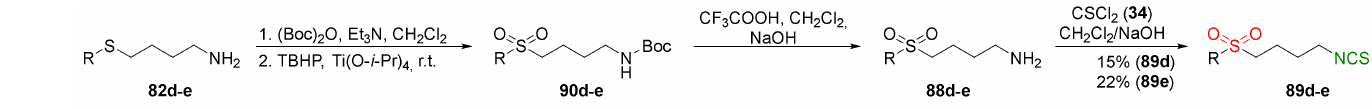
Figure 23. Synthesis of sulfoxide 84a – c and sulfone 89a – c analogues of SFN. Sulfone analogues with tetrazole and thiazole moieties 89d – e were obtained from amines 82d – e prior to Boc protection of amino groups, and oxidation formed N -Boc amines to sulfone analogues 90d – e . Removal of the Boc protecting group in 90d – e , followed by the reaction free amines 88d – e with thiophosgene, allowed to obtain the final sulfone analogues 89d – e in low yields (Figure 24).